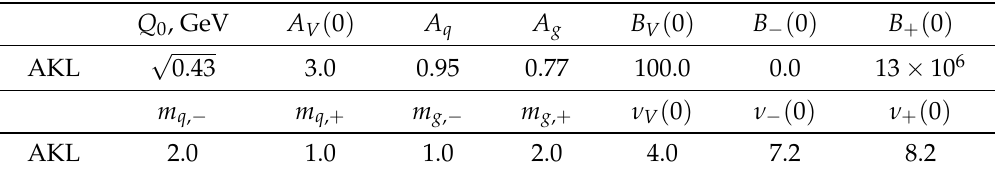
Table 1. The fitted values of various parameters involved in our analytical expressions for PDFs in the